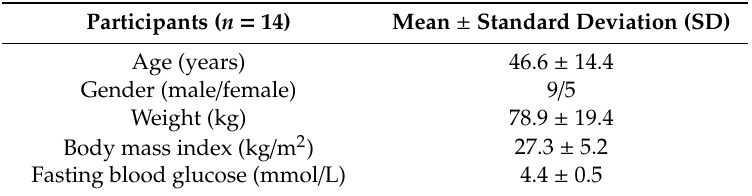
Table 2. Demographics of study